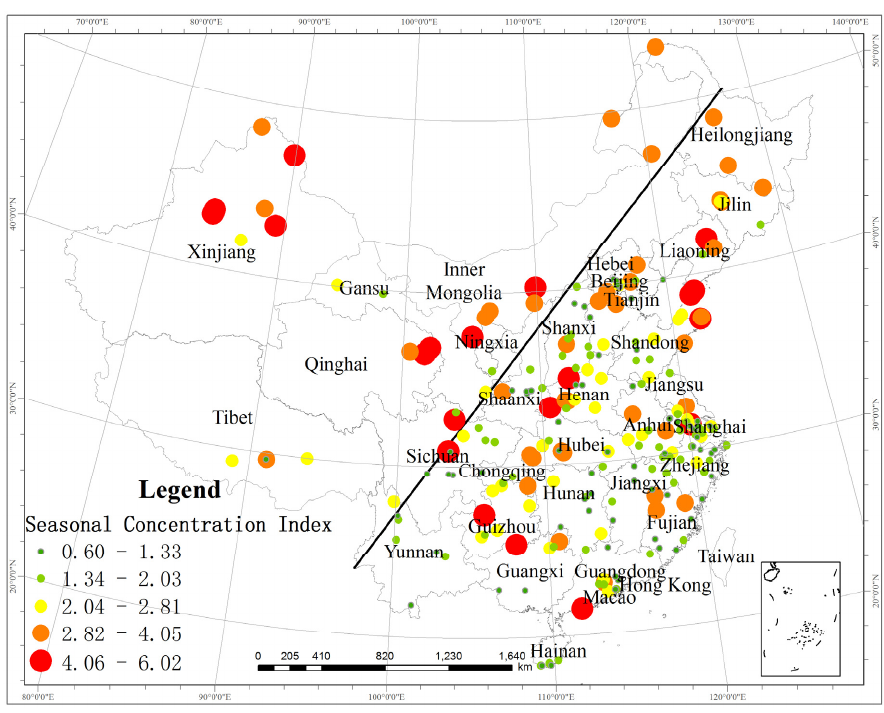
Figure 4. Spatial distribution of the seasonal concentration index in scenic